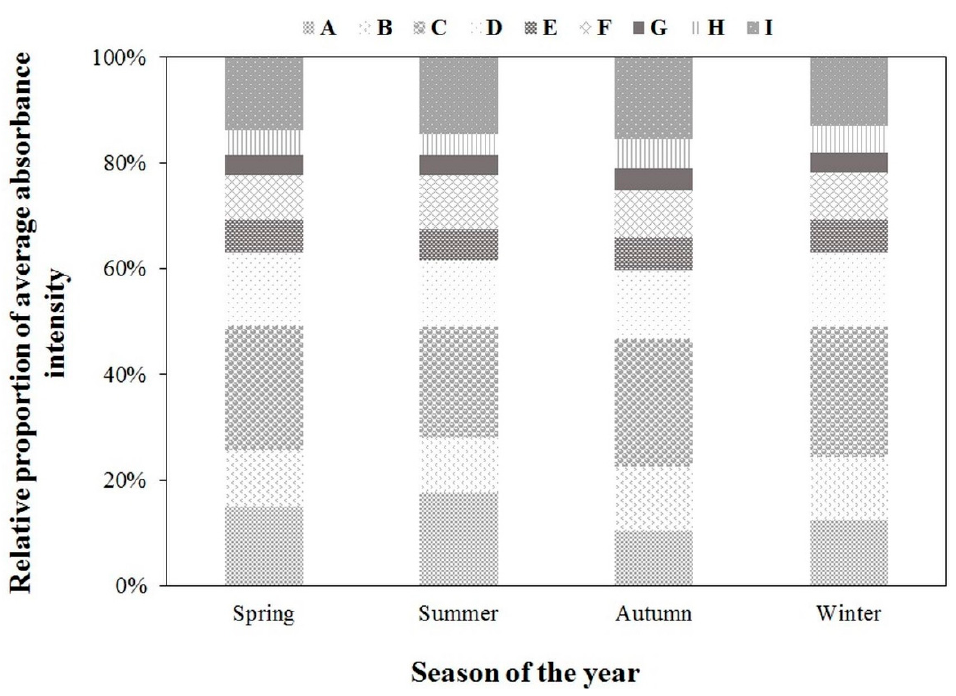
Figure 3. Distribution of absorbance intensity for each set of peaks found in the FTIR analysis of biosolids samples for each season of the year. Each box in the bars represents the absorbance peaks ordered according to wavelength: (A) 3400–3500 cm − 1 , (B) 2850–2930 cm − 1 , (C) 1650–1750 cm − 1 , (D) 1630–1650 cm − 1 , (E) 1540–1550 cm − 1 , (F) 1430–1450 cm − 1 , (G) 1380–1400 cm − 1 , (H) 1230–1250 cm − 1 and (I) 875–1050 cm − 1 .